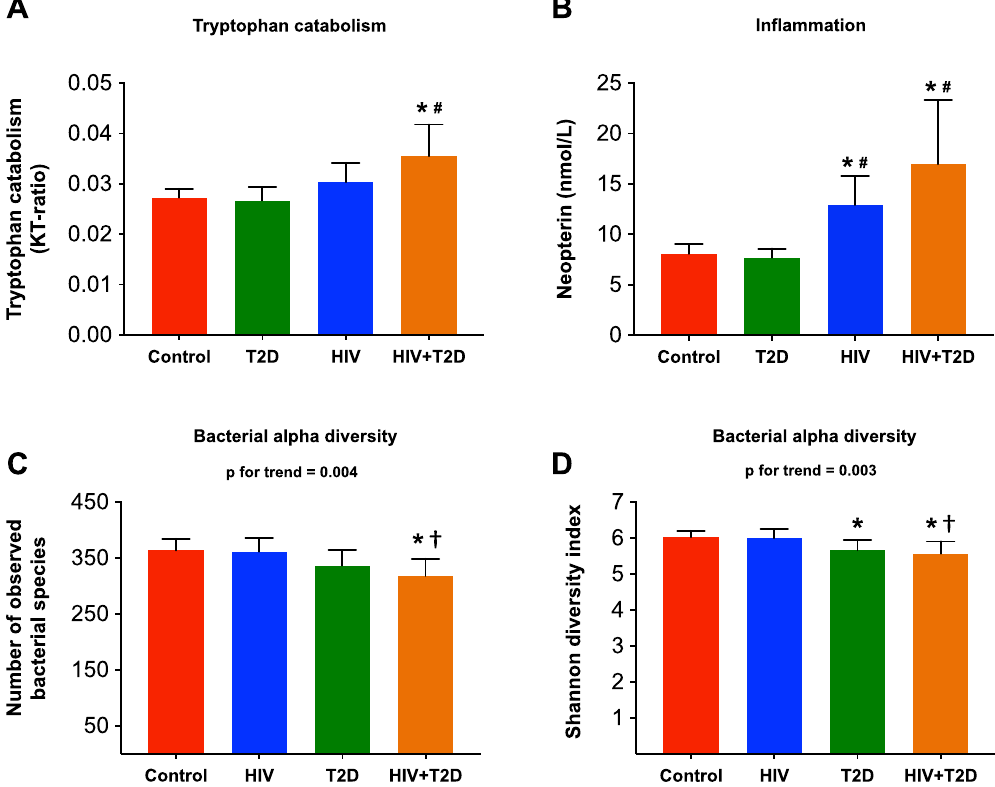
Figure 1. The impact of HIV, T2D and both (HIV + T2D) on ( A ) tryptophan catabolism (KT-ratio), ( B ) inflammation (neopterin), ( C and D ) gut microbiota diversity (number of observed bacterial species and Shannon diversity index). Controls (red), HIV only (blue), T2D only (green) and HIV-infected with T2D (orange). * p < 0.05 vs. controls, # p < 0.05 vs. T2D only, † p < 0.05 vs. HIV only.